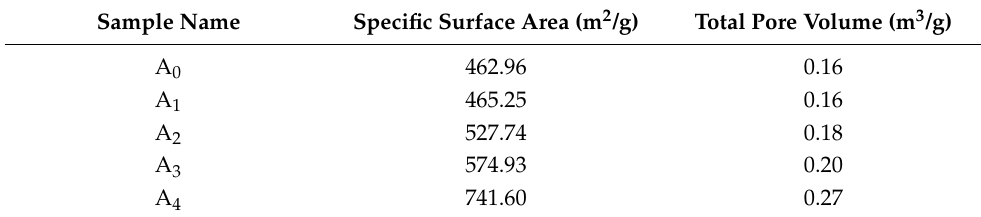
Table 1. Porous structure parameters of different